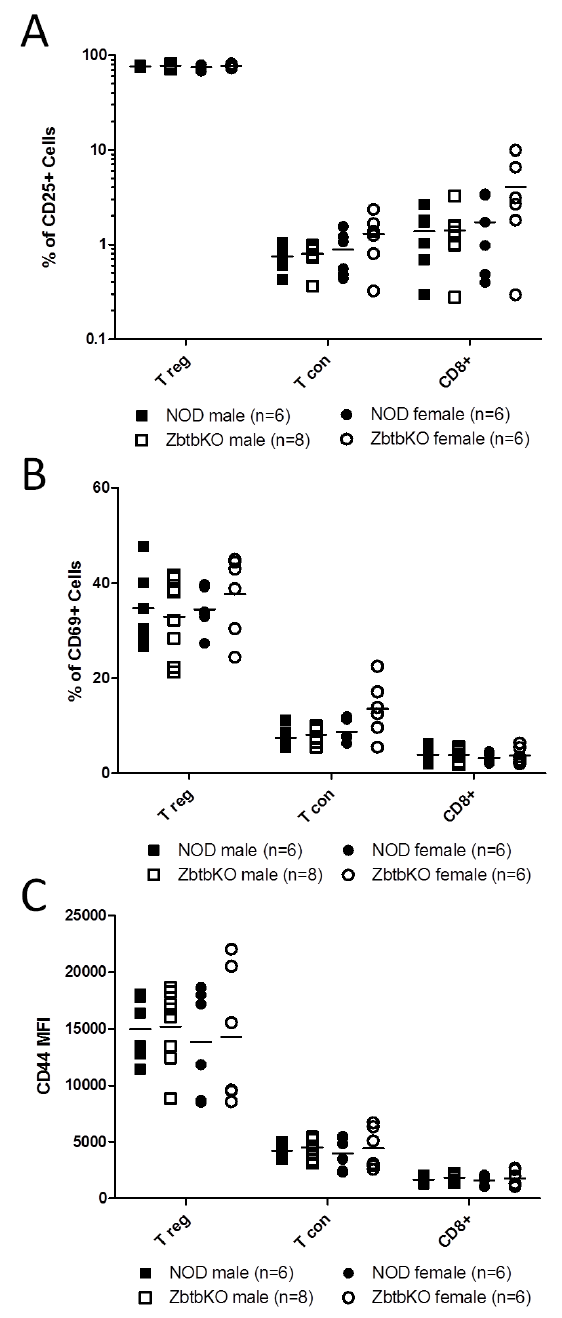
Figure 3. Activation markers on lymphocytes from pancreatic draining lymph node of Zbtb32 -/- mice. Lymphocytes from the pancreatic draining lymph node of male and female NOD and NOD. Zbtb32 -/- mice were stained for activation markers. Flow cytometry was used to determine cell surface expression of CD25 ( A ) CD69 ( B ) and CD44 ( C ) on CD4 + Foxp3 + (Tregs), CD4 + Foxp3 - (Tcon) and CD8 + T cells. The data were combined from two independent repeats of this